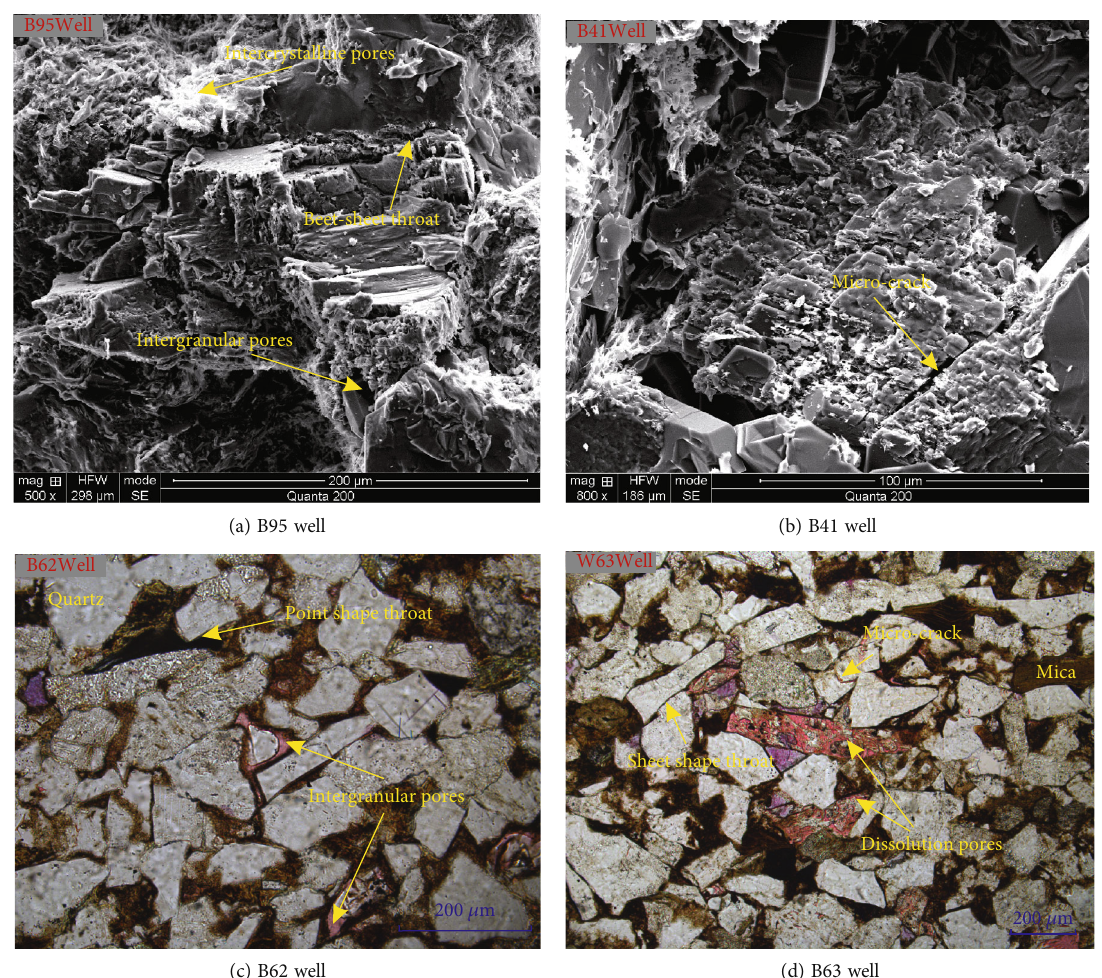
Figure 4: The pore and throat characteristics of the samples were